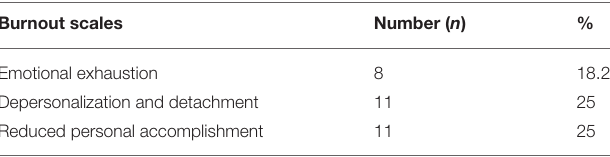
TABLE 2 | Dimensions of different burnout scales among palliative care